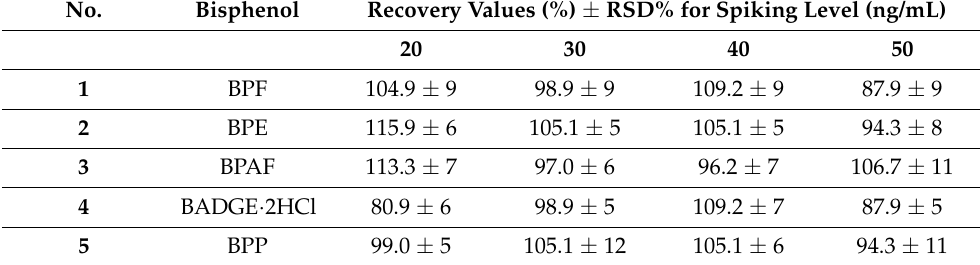
Table 3. The mean recovery values and RSD% of the studied bisphenols in spiked amniotic fluid samples.